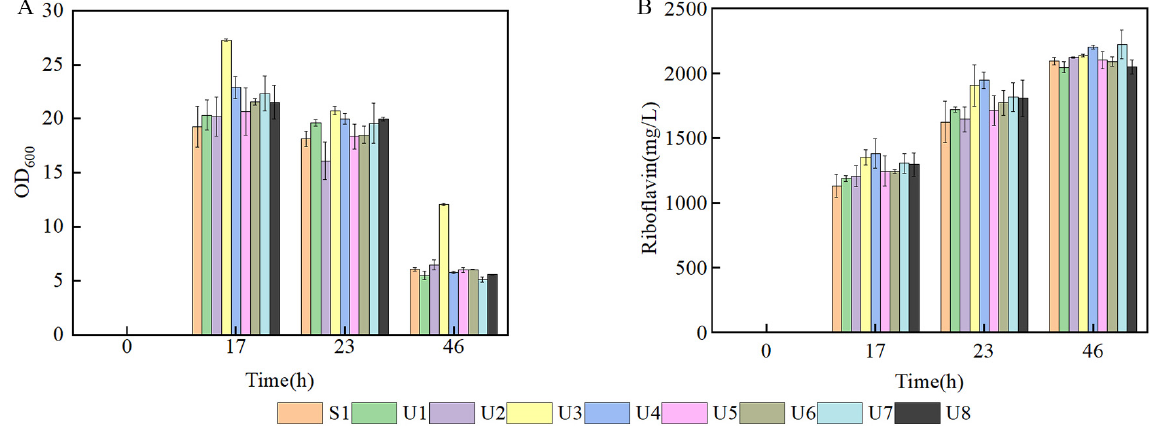
Figure 2. Batch fermentation by strains S1 and U1-U8 in 500 mL shake flasks containing 80 mL of YP